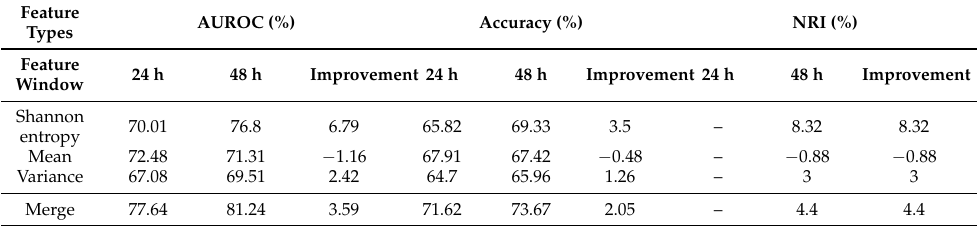
Table 11. Comparison of 24 h and 48 h feature windows on AUROC, Accuracy, NRI.